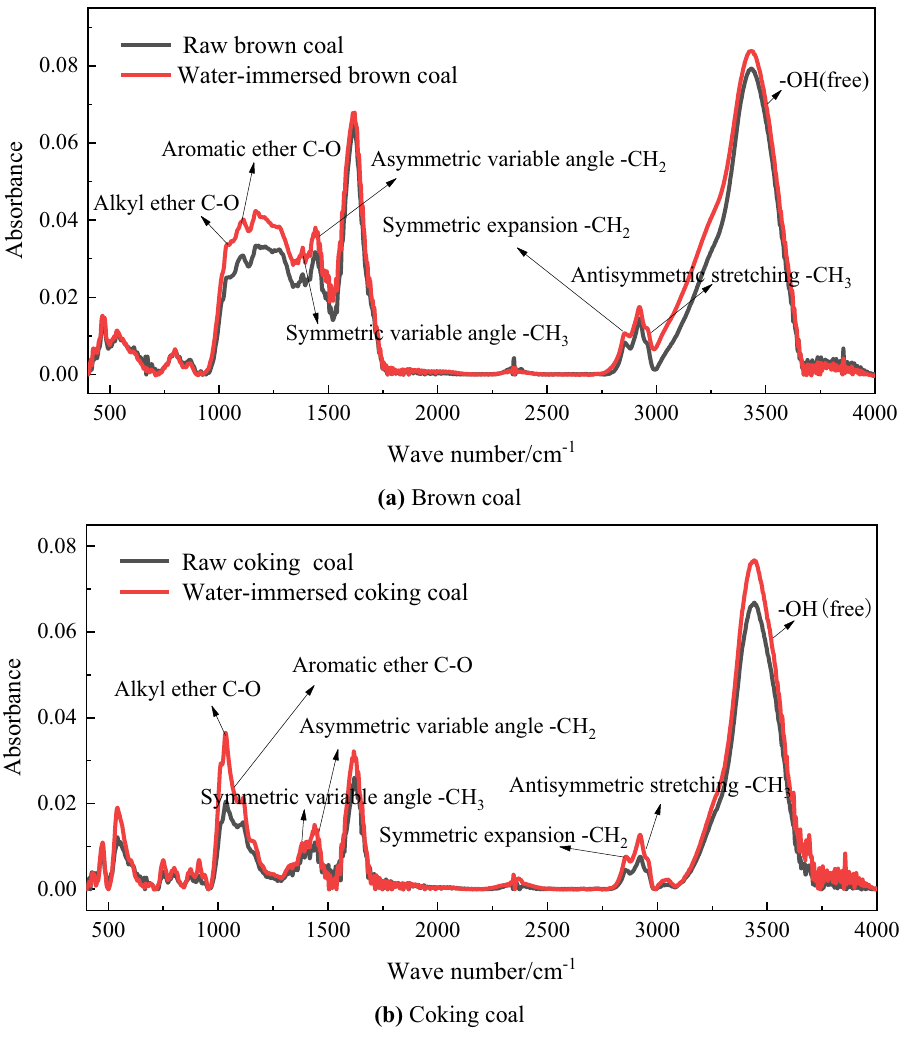
Figure 3. Infrared spectral curves of raw coal samples and water-immersed coal